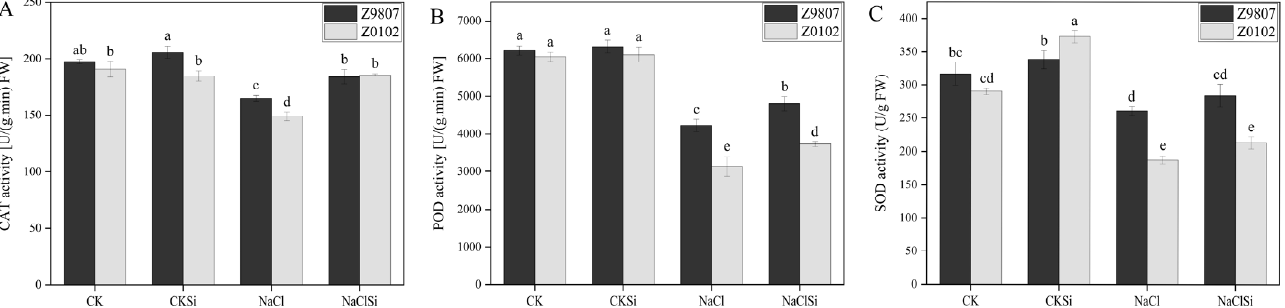
Figure 3. Effect of Si on MDA content in cotton leaves under salt stress. Error bars represent the standard error ( n = 3). Different letters mean significantly different among treatments at p ≤ 0.05.